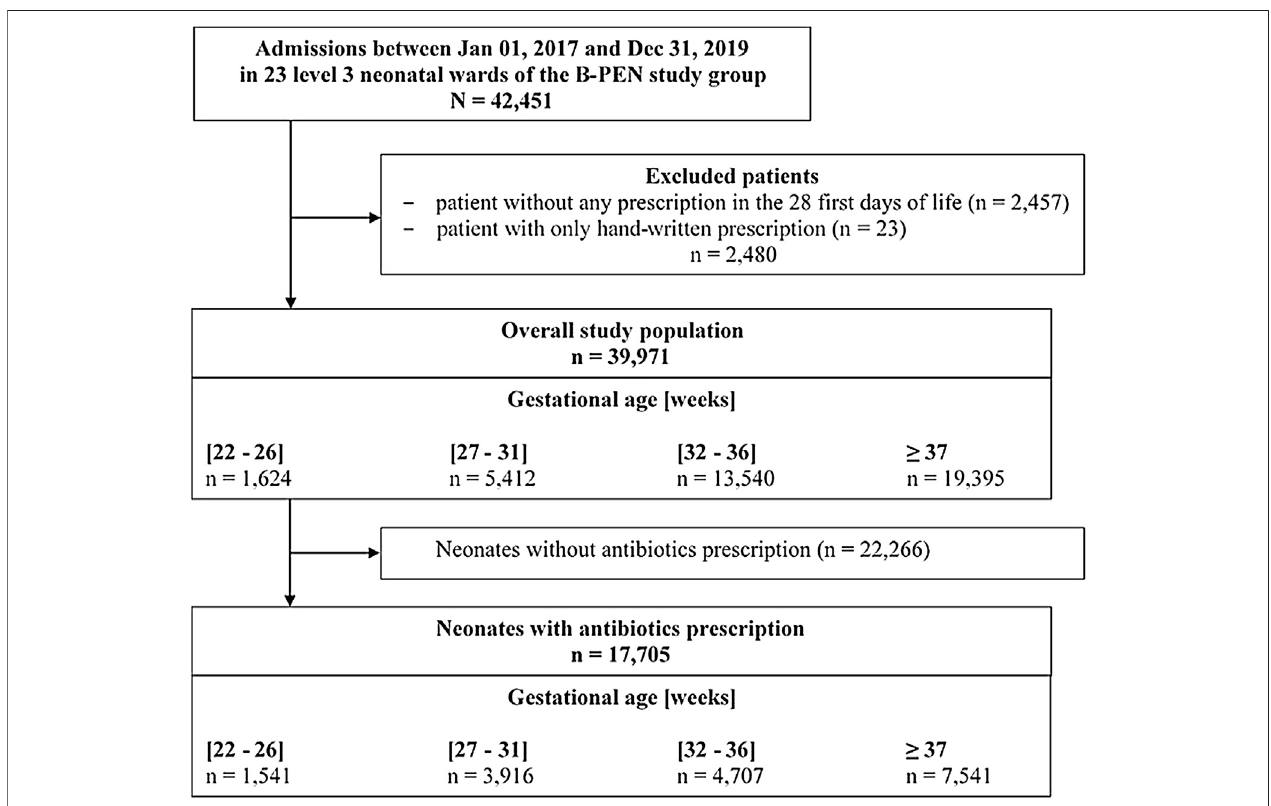
FIGURE 1 | Flow chart of the study